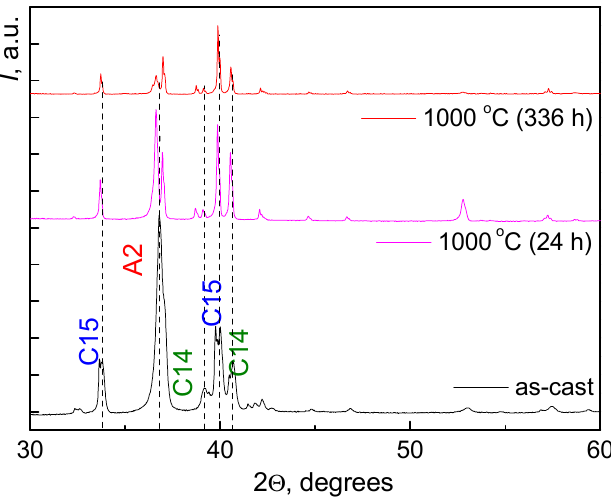
Figure 4. Diffraction patterns of the TiZrHfMoCrCo alloy in the as-cast state (black line) and after annealing (red line: 1000 °C for 336 h; and pink line: 1000 °C for 24 h).